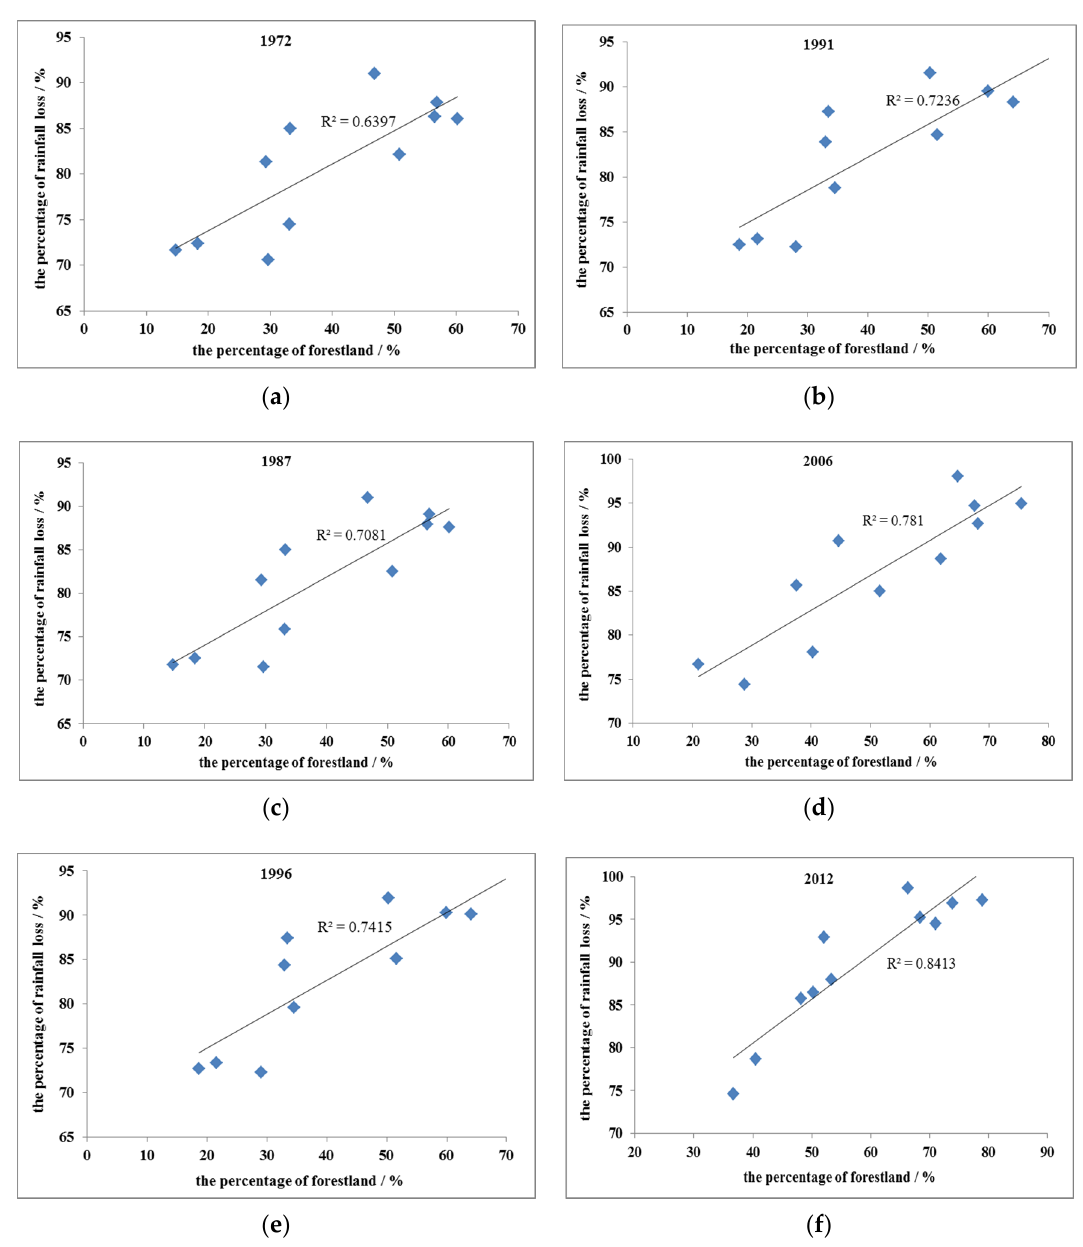
Figure 13. The correlation between the percentage of rainfall loss and the percentage of forestland.